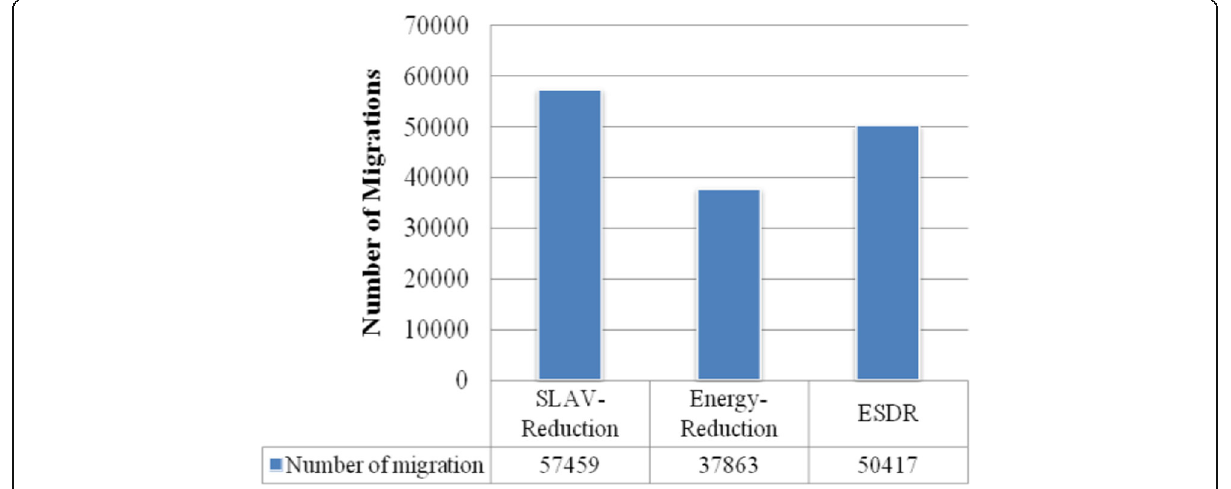
Fig. 5 Comparison of the number of migrations in different approaches